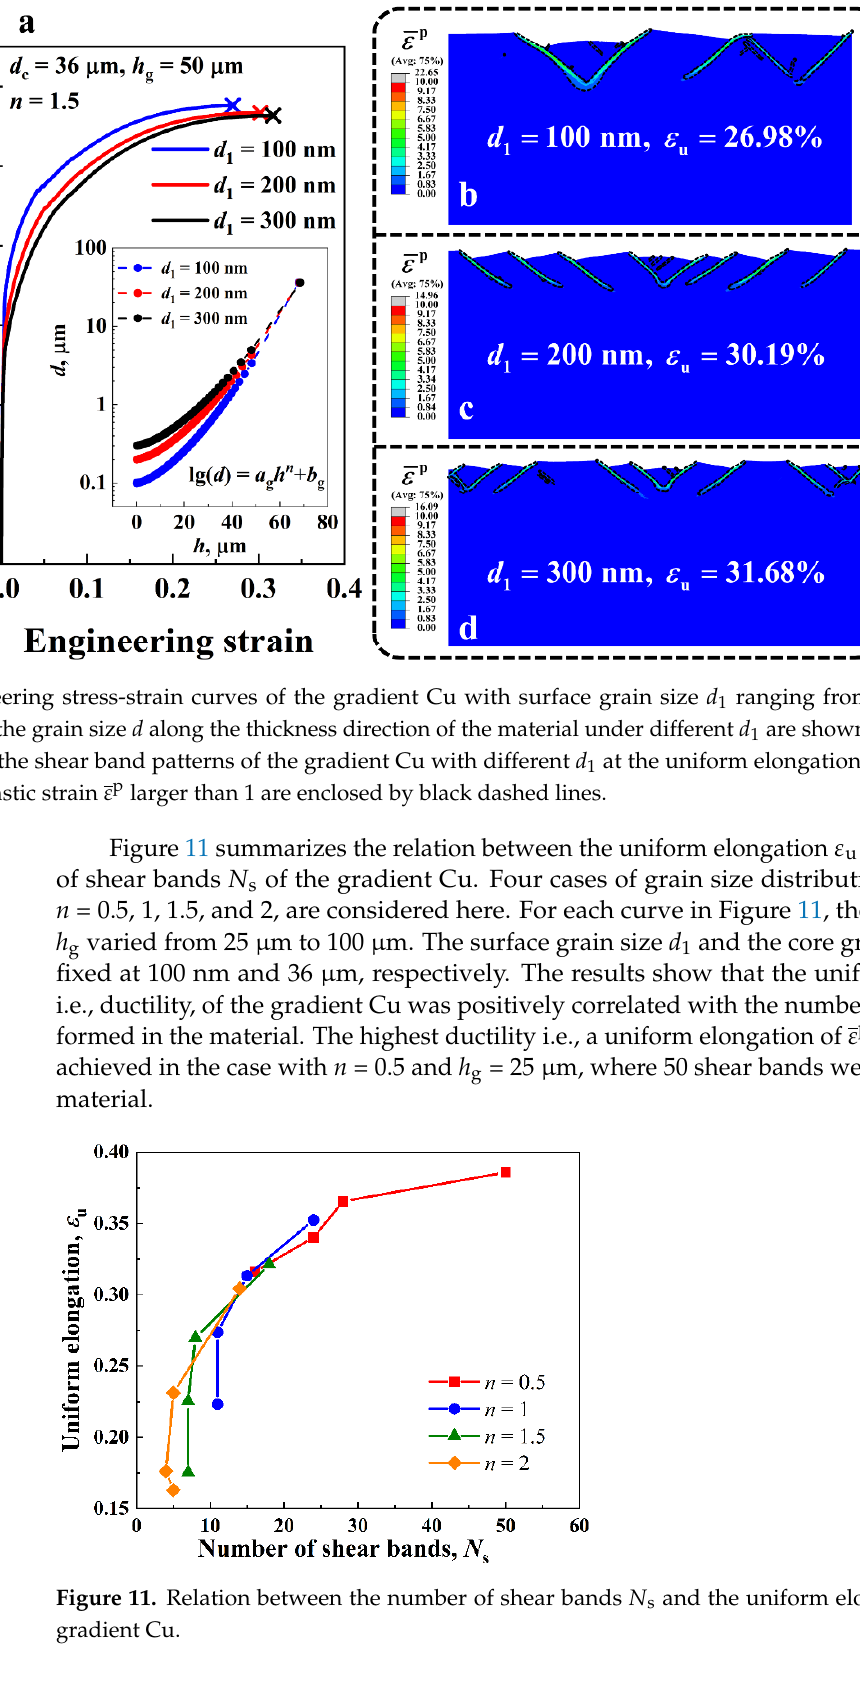
of the u of the u